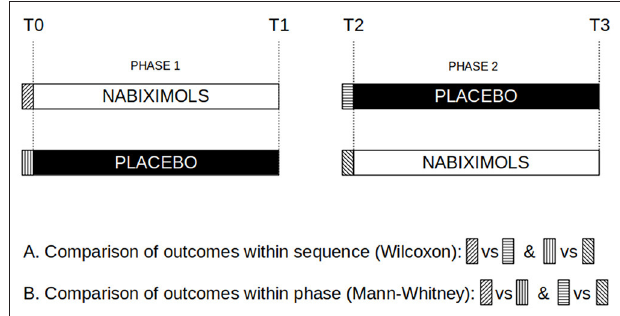
FIGURE 2 | Risk of bias assessment. Graphical representation of assessments to compares outcomes within sequence (T0 vs. T2) and within phase (nabiximols vs. placebo at T0 and